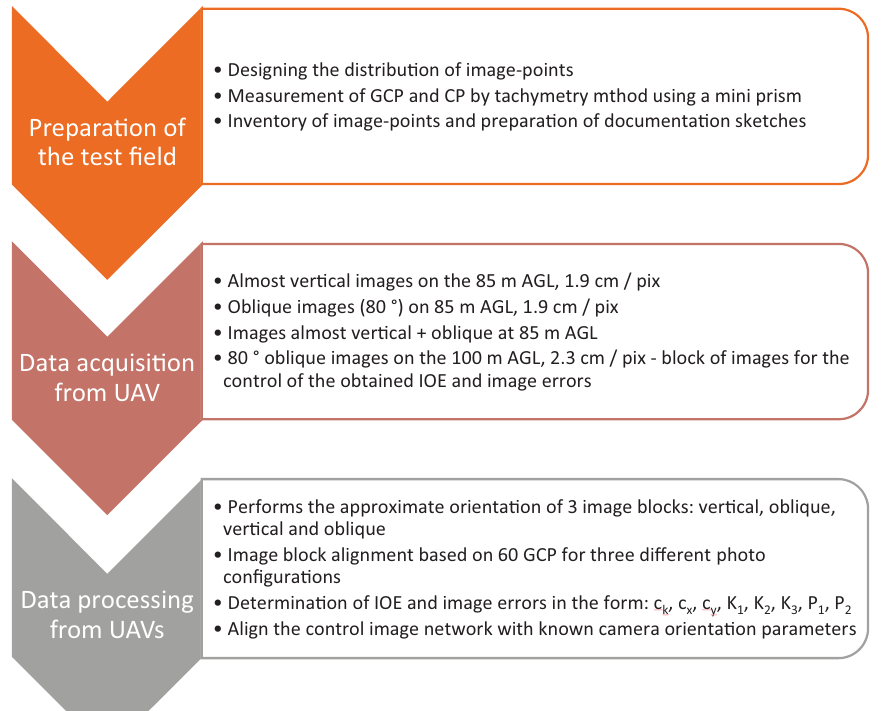
Figure 5. Diagram of the activities carried out in the presented